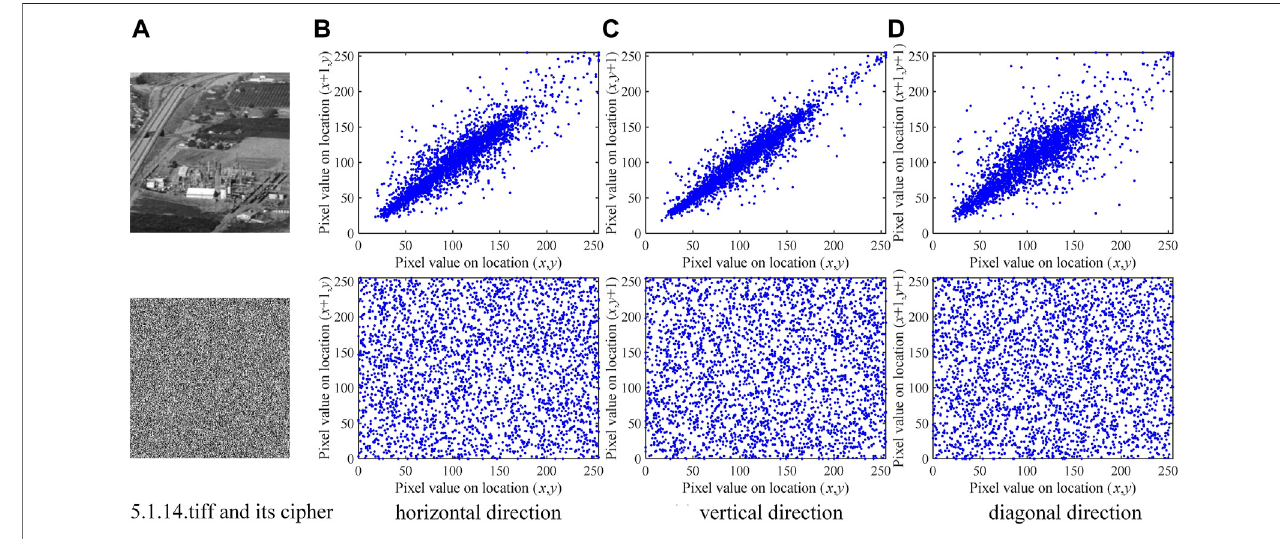
FIGURE 7 | Correlation test of image 5.1.14.tiff [43] and its cipher in three directions.